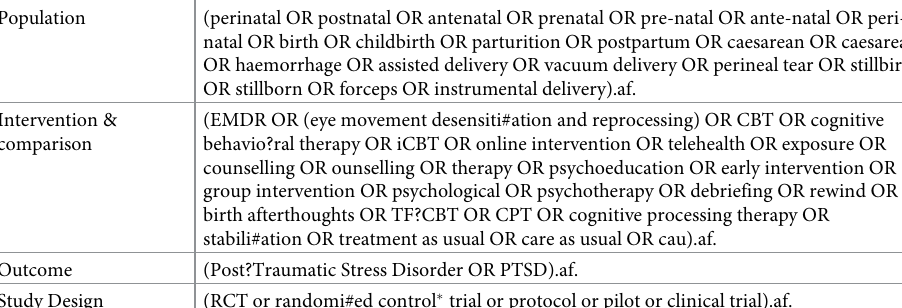
Table 2. PICOS framework.